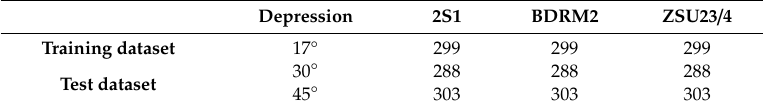
Table 10. The dataset with large depression angle variations.